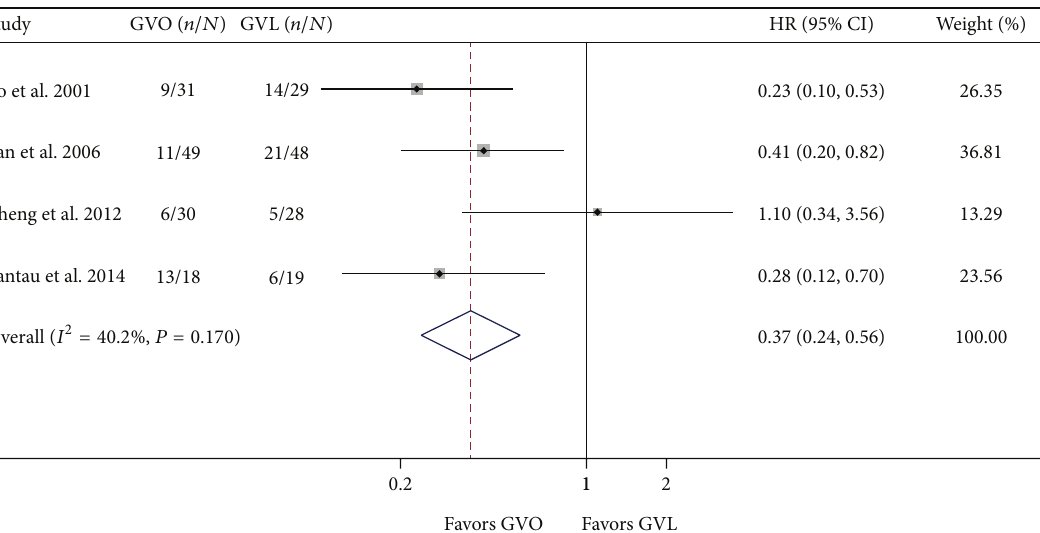
Figure 4: Comparison of rebleeding of gastric varices in the GVO and GVL groups. GVO, cyanoacrylate injection; GVL, band ligation; CI, confidence interval; HR, hazard ratio.